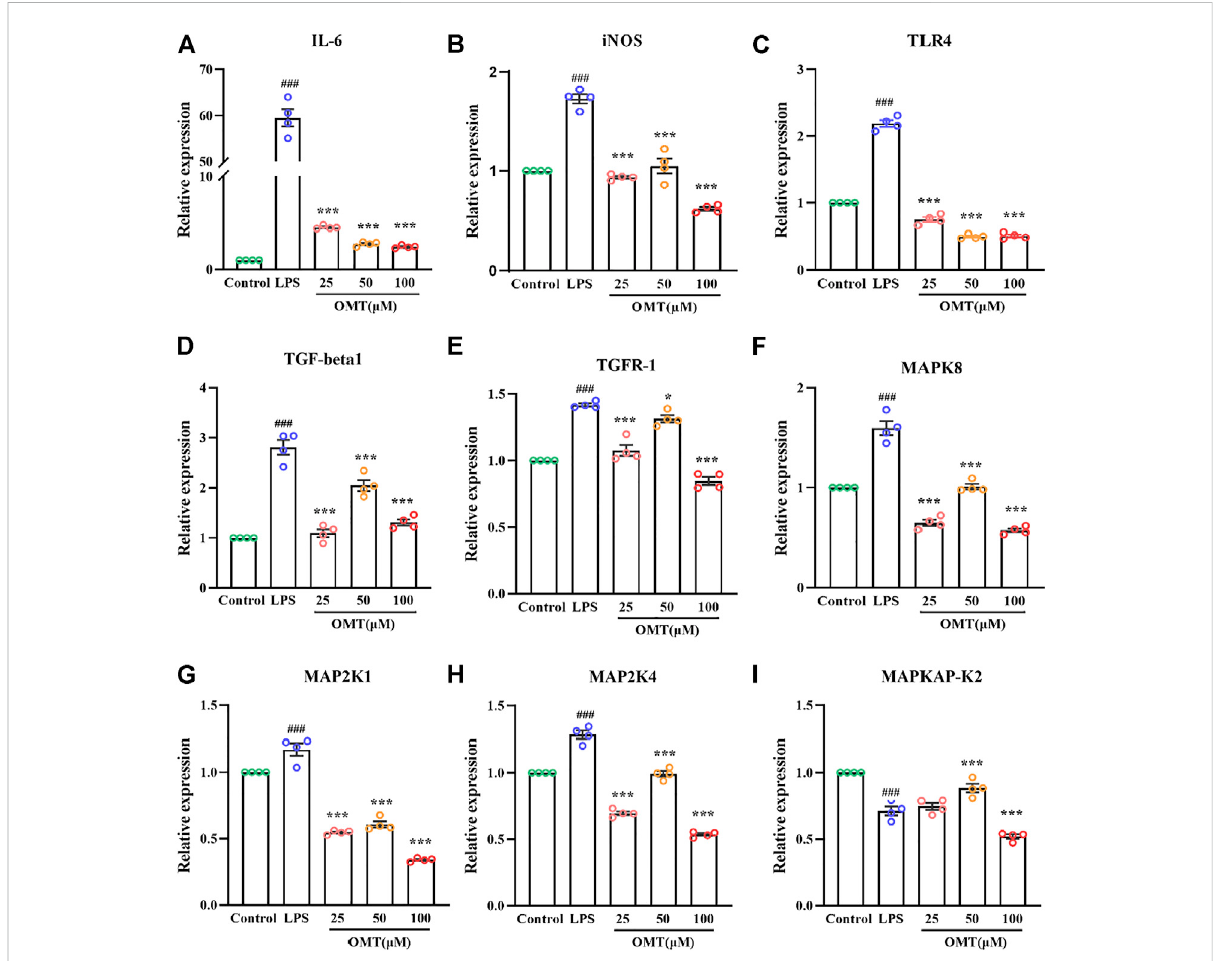
FIGURE 11 Effects of OMT on the mRNA expression of LPS-induccd RAW264.7 cell in fl ammation model. (A – E) The mRNA expression of in fl ammatory factors (IIL-6, iNOS), and receptors (TLR4, TOF-R-1, TGF-betal). (F – I) The mRNA expression of MARK signaling pathway targets (MAPK8, MAP2KI, MAP2K4, MAPKAP-K2). Values represent average ± S.D. Signi fi cant differences among different groups are indicated as ### p < 0.001 vs. control; * p < 0.05, ** p < 0.01vs. *** p < 0.001 vs. LPS